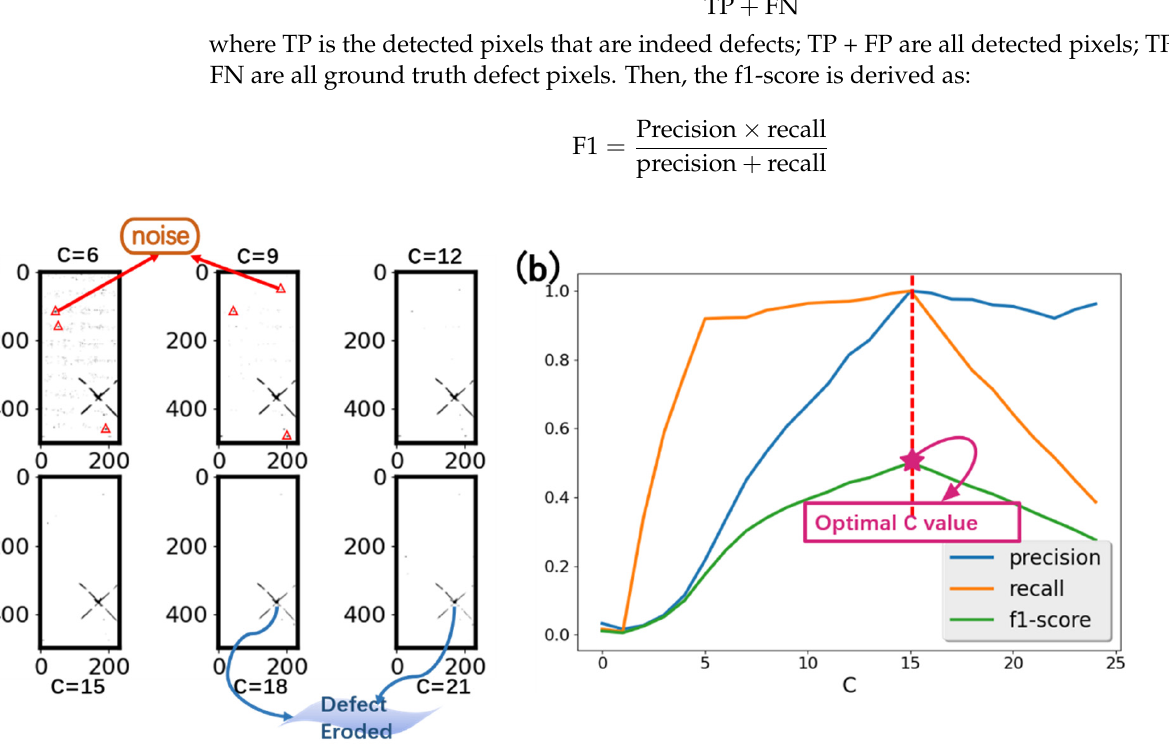
Figure 3. ( a ) detected defect pixels under different values of C. Some false detections are highlighted with red a circle. With a higher C value, true defects are eroded. ( b ) Precision, recall and f1-score change according to C value upon a training set of 20 samples.